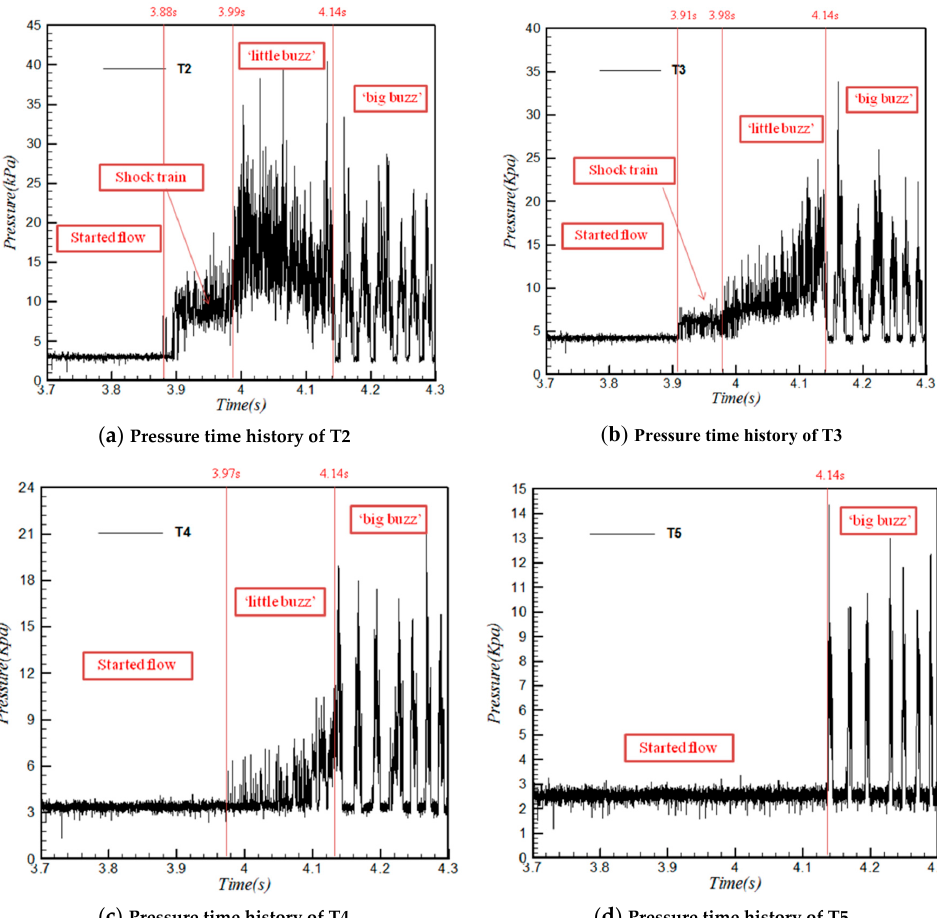
Figure 12. Analysis of pressure time history of T2–T5 (3.7–4.3 s).